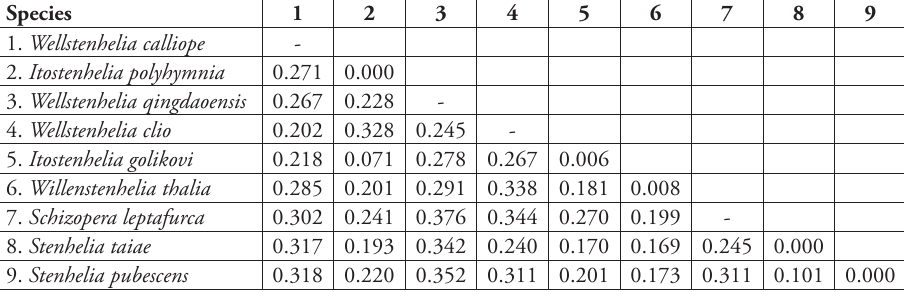
Table 3. Average pairwise maximum likelihood distances (TN model) among mtCOI sequences be- tween each morpho-species (lower diagonal) and within morho-species (diagonal).